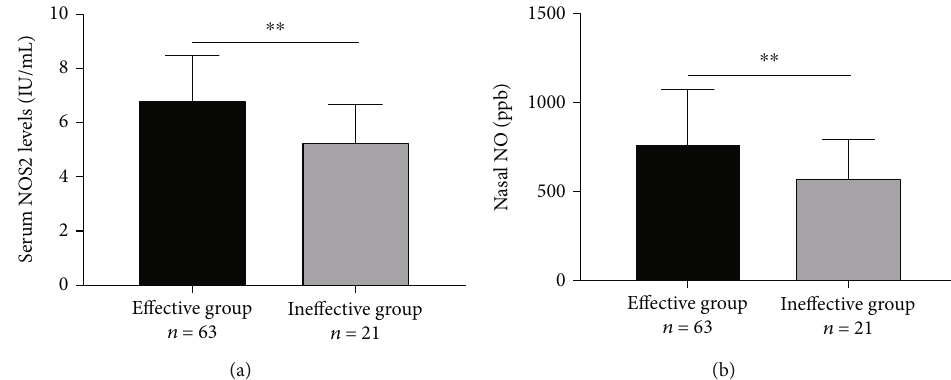
Figure 3: Serum NOS2 and nNO levels in between the e ff ective group and the ine ff ective group. (a) Serum NOS2 concentrations were higher in the e ff ective group than in the ine ff ective group. (b) nNO levels were clearly raised in the e ff ective group in comparison with the ine ff ective group. NOS2: inducible nitric oxide synthase; nNO: nasal nitric oxide, ∗∗ P < 0 : 01